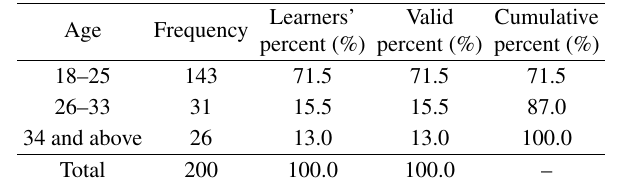
Table 2 Age distribution of the participants.